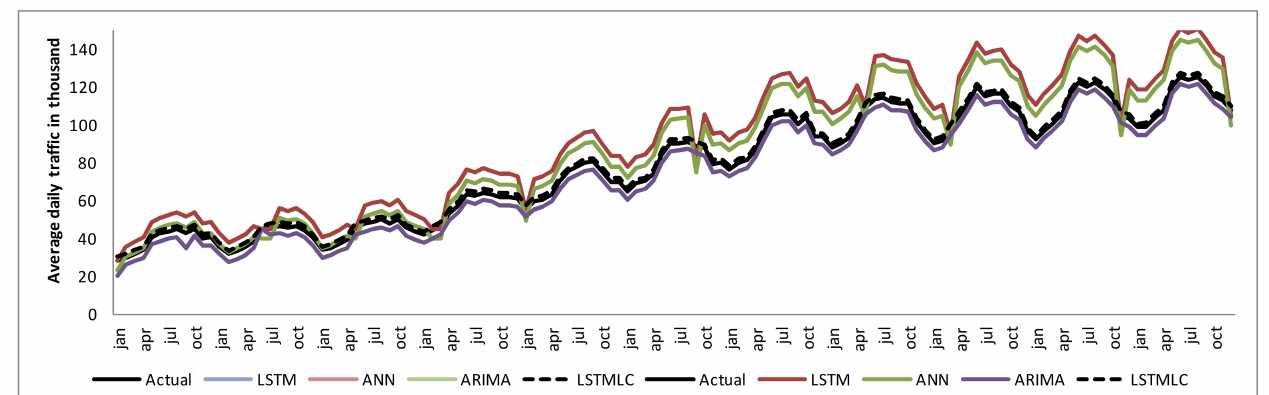
Figure 10. Observed vs. predicted model